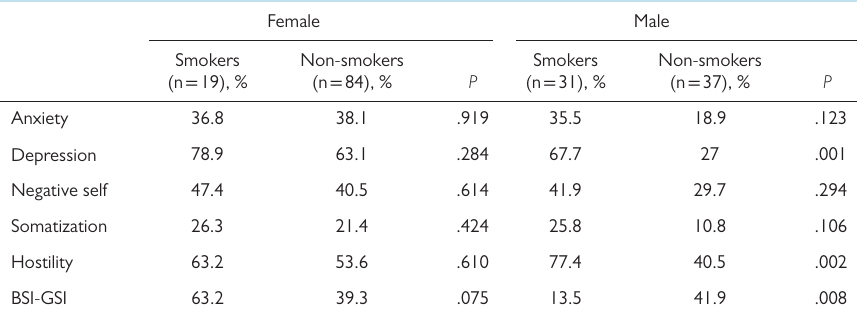
Table 4. The Rate of BSI Scores at the Psychopathological Levels in Adolescents According to Gender, Smoking, or